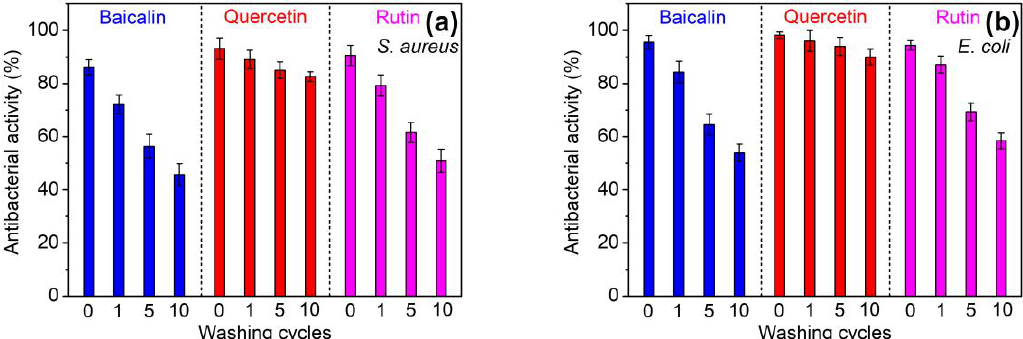
Figure 8. Antioxidant properties of polyamide fibers treated using 2% owf ( a ) and 10% owf ( b ) flavonoids after repeated laundering.